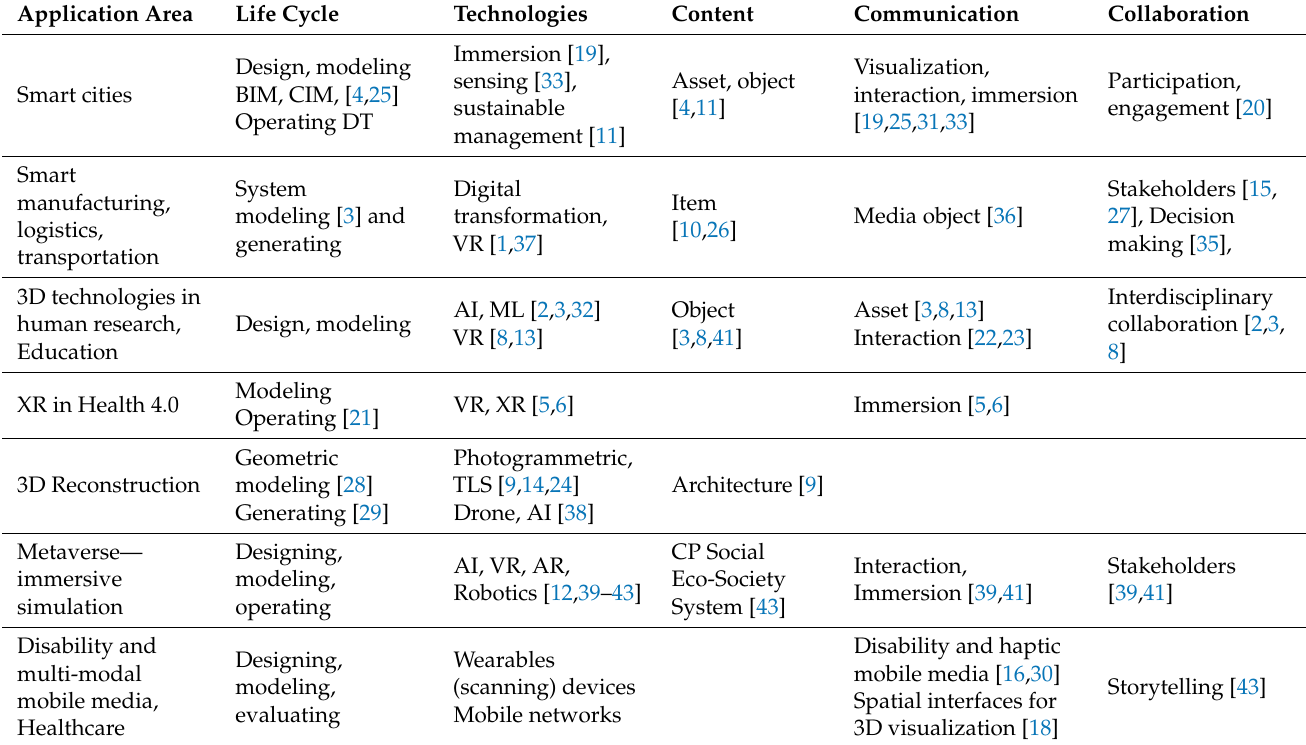
Table 3. Clustering the corpus with respect to AA, stages in life cycle, ET, DT dimensions and features.